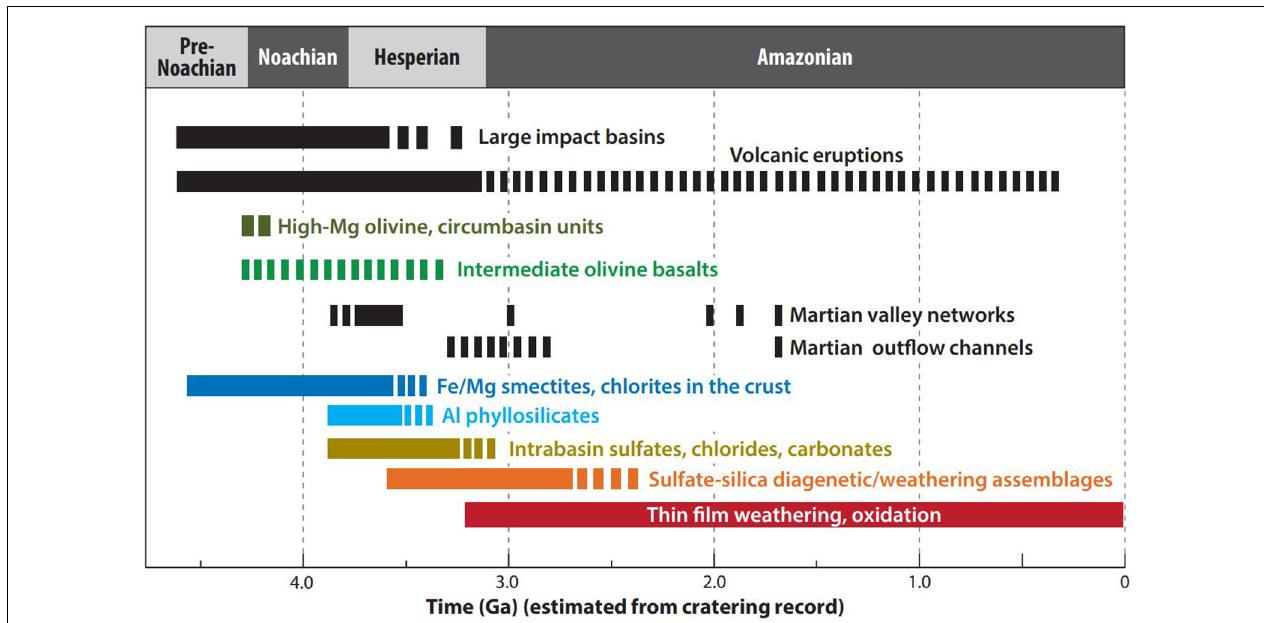
FIGURE 8 | Timeline of the major processes affecting the mineralogic composition of Mars and the ages of large-scale compositional units (Kneissl et al.,